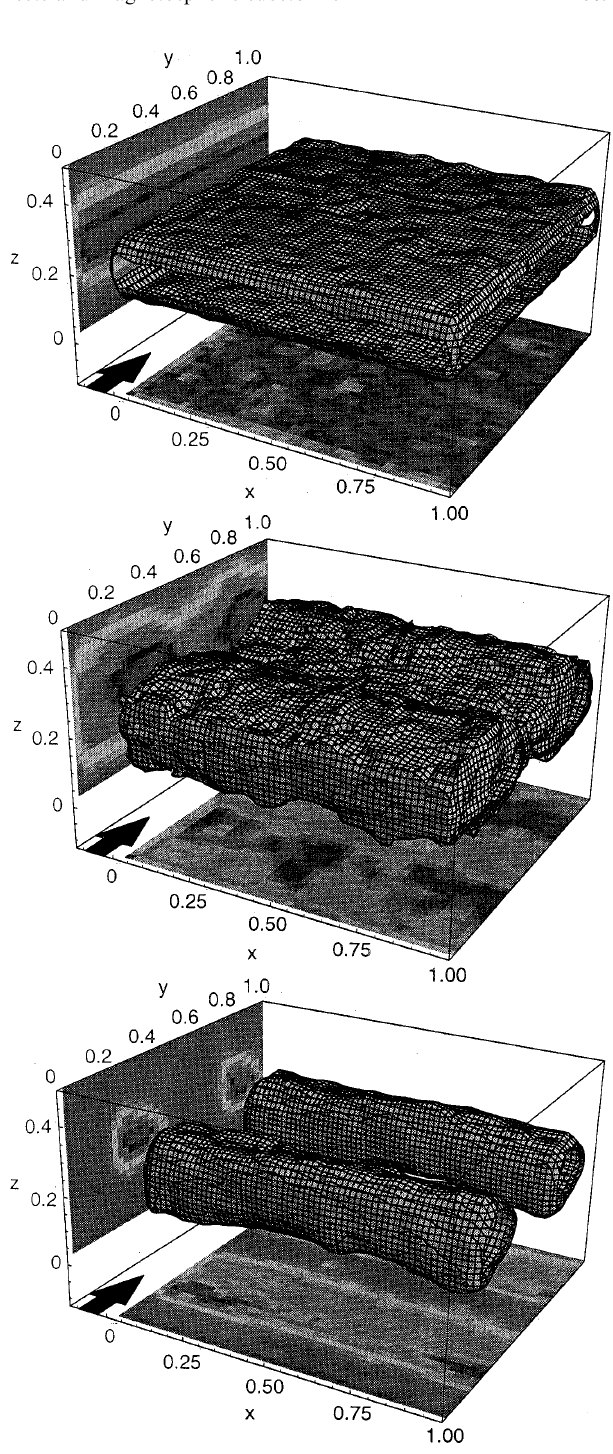
Fig. 4. Instability of a three-dimensional Harris sheet equilibrium for a mass ratio M (cid:136) 1. The images show ion density isosurfaces at t X 0 (cid:136) 1 : 4, 9.8 and 19.6, respectively. The left box side shows isodensity contours for a cut through the box at x (cid:136) 6 L z (cid:136) 0 : 5 D . The bottom plane shows isodensity contours for a cut through the box at z (cid:136) 3 L z (cid:136) 0 : 25